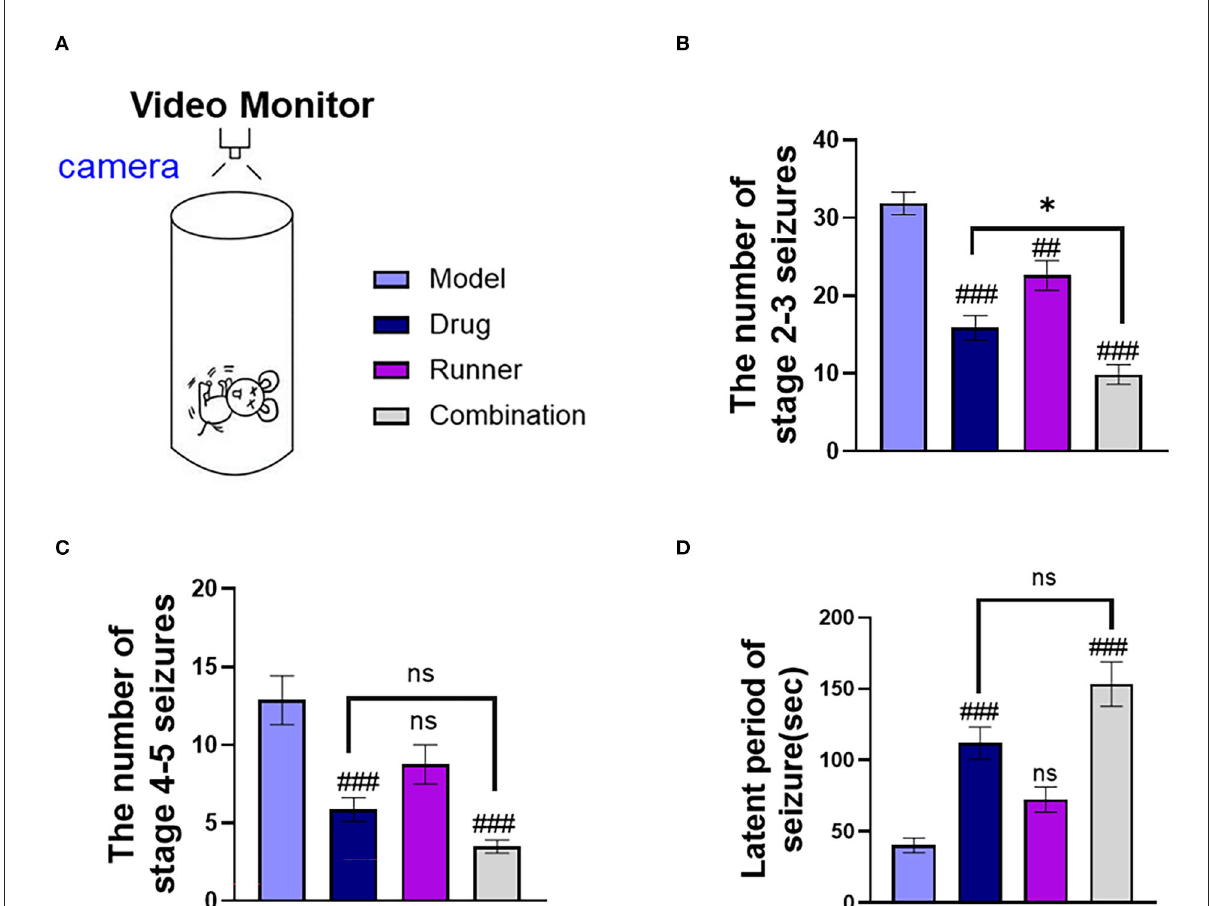
FIGURE2 Seizure status of mice in each group. (A) A monitoring camera for continuous observation for 9h. (B,C) The number of stages 2–3 and stages 4–5 seizures. (D) Latent period of tonic–clonic seizure in each group. Data were shown as mean ± SEM. ns > 0.05, * P < 0.05, ## P < 0.01, ### P < 0.001, comparison of the model group with each treated group (two-way